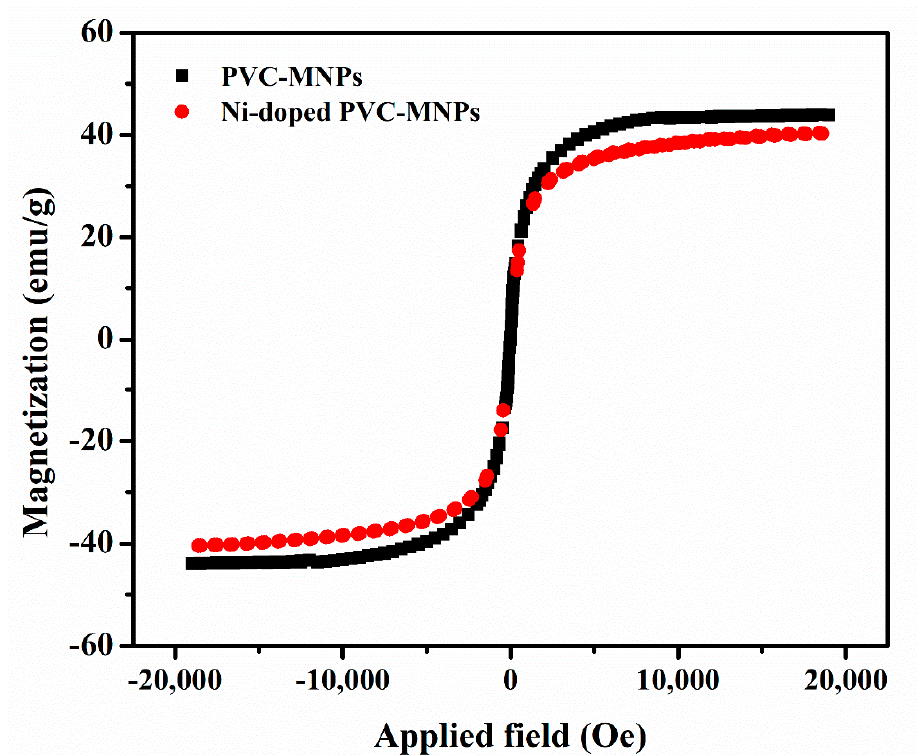
Figure 5. Vibrating sample magnetometry (VSM) curves of the synthesized PVC–MNPs and Ni-doped PVC–MNPs.